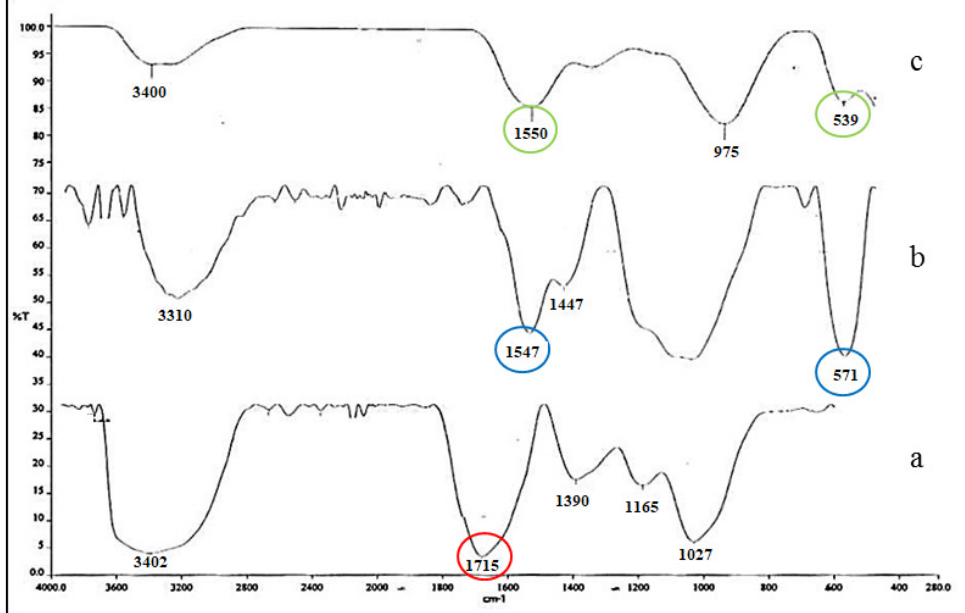
Figure 3. FTIR spectra of ( a ) graphene oxide, ( b ) magnetic graphene oxide, and ( c ) mycotoxins loaded with MGO.